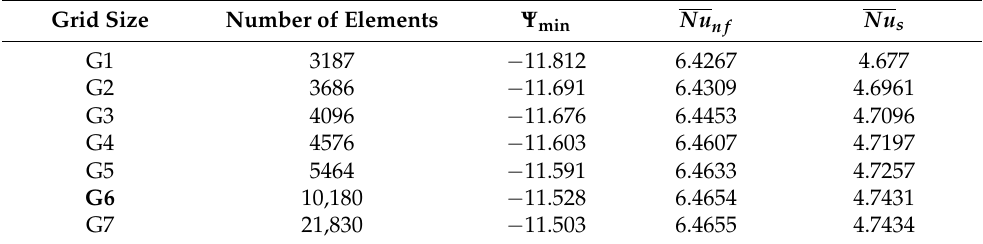
Table 1. Grid testing for Ψ min , Nu nf , and Nu s at different grid sizes for Ra = 10 6 , Da = 10 − 3